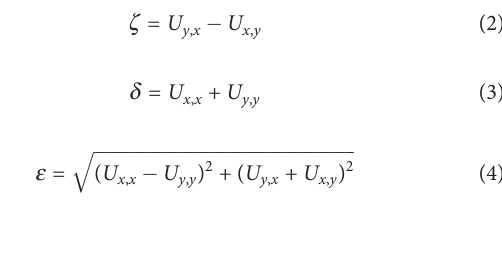
(Figure 1E) reproduced by the JCOPE-T. The satellite product provides the climatological mean dynamic topography (Figure 1A) and mean geostrophic current fi eld (Figure 1B) over the period of 1993 – 2012 with a horizontal resolution of 1/8°. The WOA provided the temperature and salinity used to calculate the buoyancy frequency (Figure 1D).